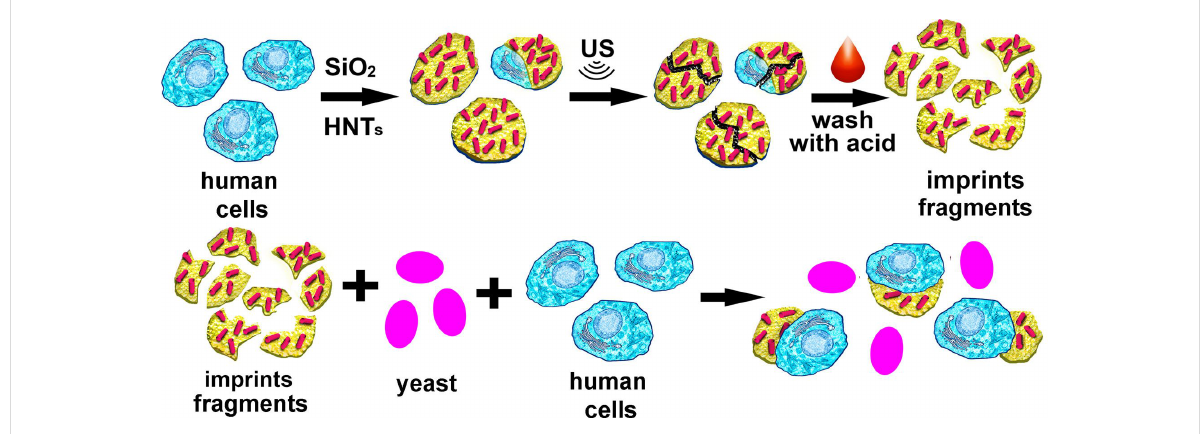
Figure 1: Production of silica/halloysite cell-mimicking imprints and recognition of human cells by the imprints in HeLa/yeast cells mixture. The imprints were obtained by destruction of inorganic shells deposited on live cells.